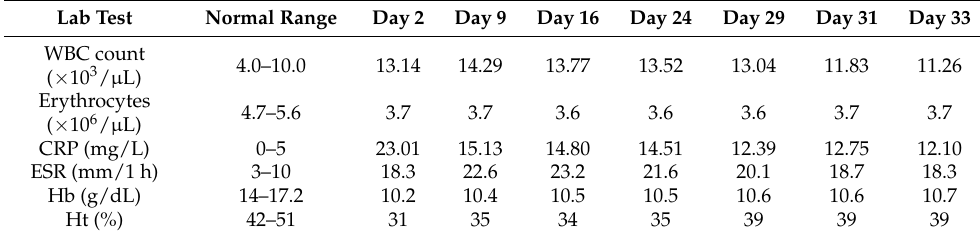
Table 2. Laboratory